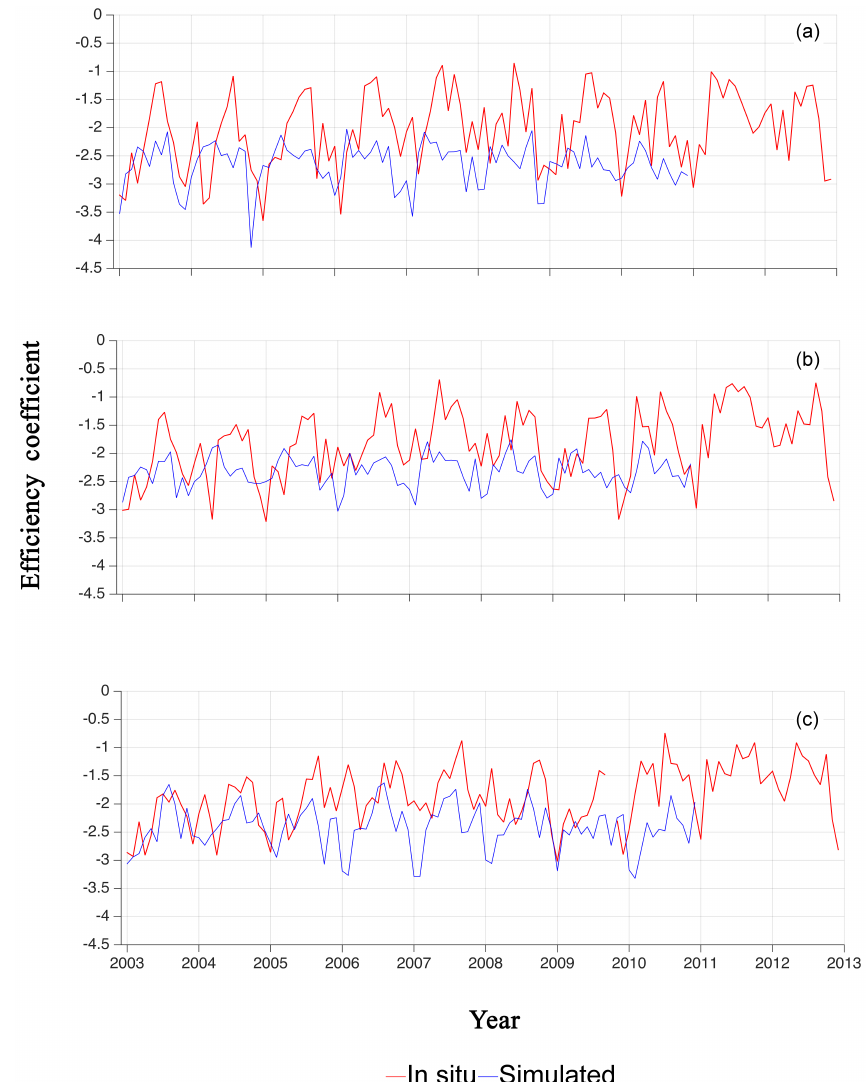
Figure 4. Efficiency coefficient calculated from in situ data (red line) and model simulations (blue line) in the three study areas (A, B, and